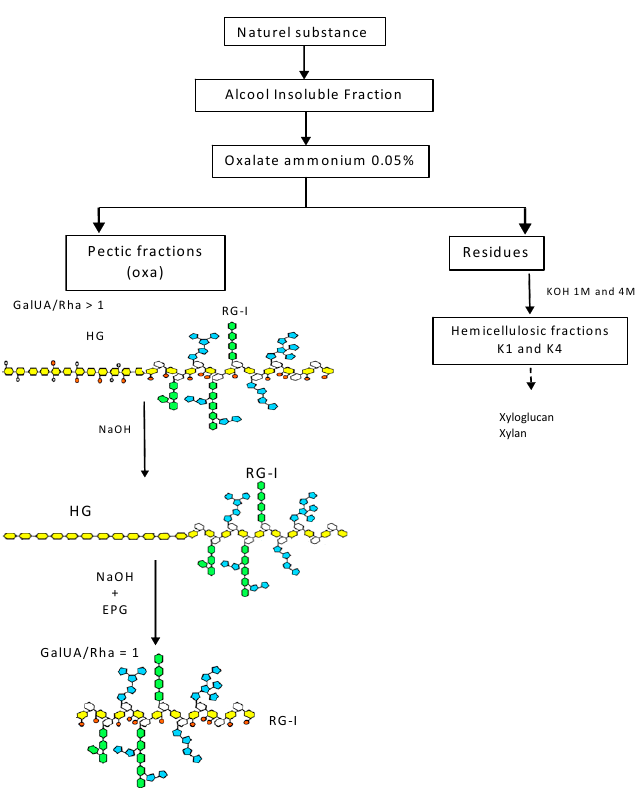
Figure 1. Scheme for the isolation of pectic and hemicellulosic fractions and the effects of endopolygalacturonase (EPG) and saponification by NaOH on the pectic material. Monosaccharides: galacturonic acid (GalUA), yellow; rhamnose (Rha), white; galactose (Gal), green; arabinose (Ara), blue; oxa, oxalate.